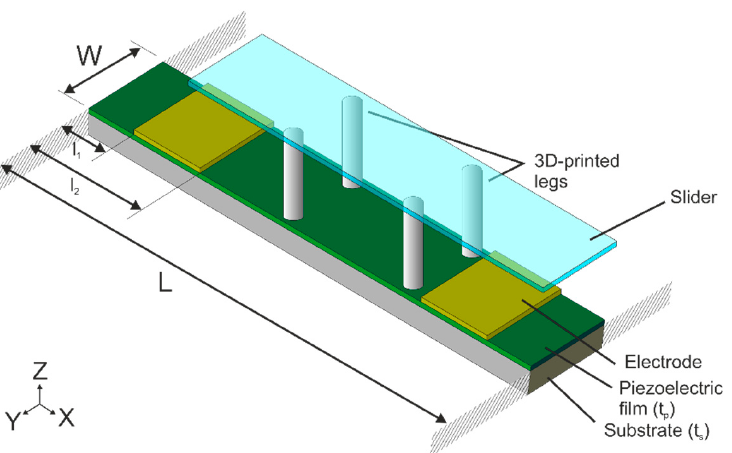
Figure 1. Device schematic of the conveyor design: a bridge structure of length L and width W consisting of a silicon substrate with a thickness t s = 30 µ m, covered by an aluminum-nitride (AlN) piezoelectric layer of thickness t p = 1 µ m. Two metallic electrodes were symmetrically placed close to the edges, from a distance l 1 to l 2 . 3D-printed resin legs were attached afterwards to ensure the contact of the vibrating structure with the slider to be